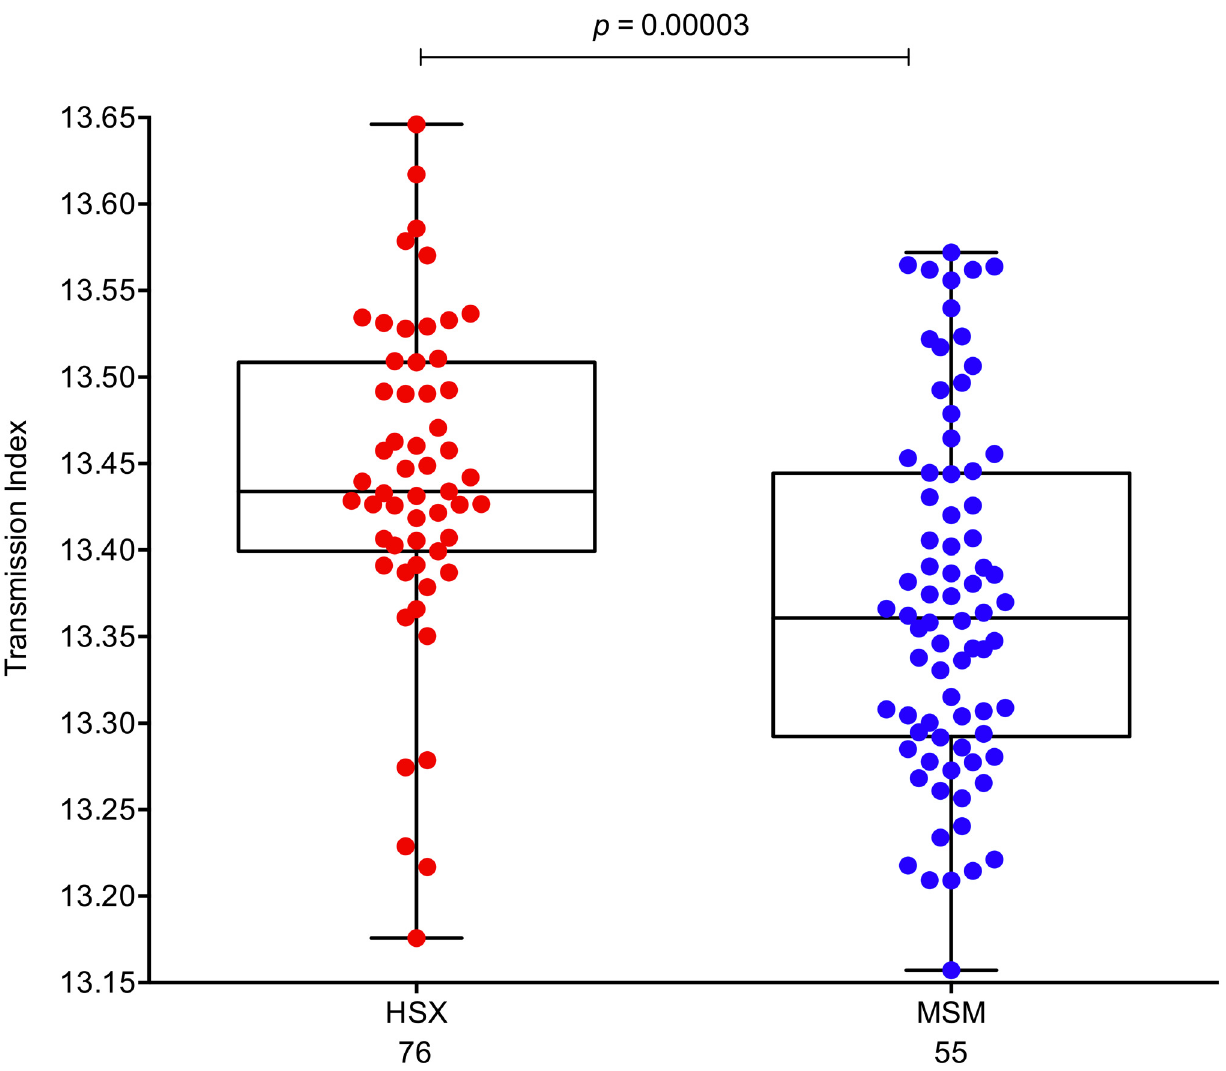
Fig 5. Selection bias intensified for HSX founder viruses compared to MSM founder viruses. The transmission index of a sequence was calculated using logistic regression with model weights taken from [12]. Black lines represent the median transmission index for the two risk groups. The overall transmission index of HSX (red circles) viruses is significantly higher than from MSM (blue circles) founder viruses ( P = 0.00003, Mann-Whitney two-tailed test). The number of subjects in each category is denoted under each group.